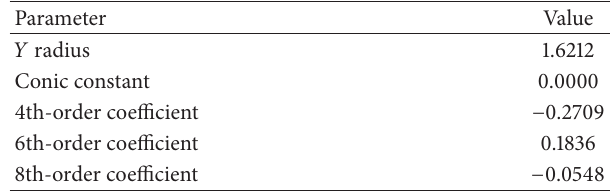
Table 5: The parameters of surface